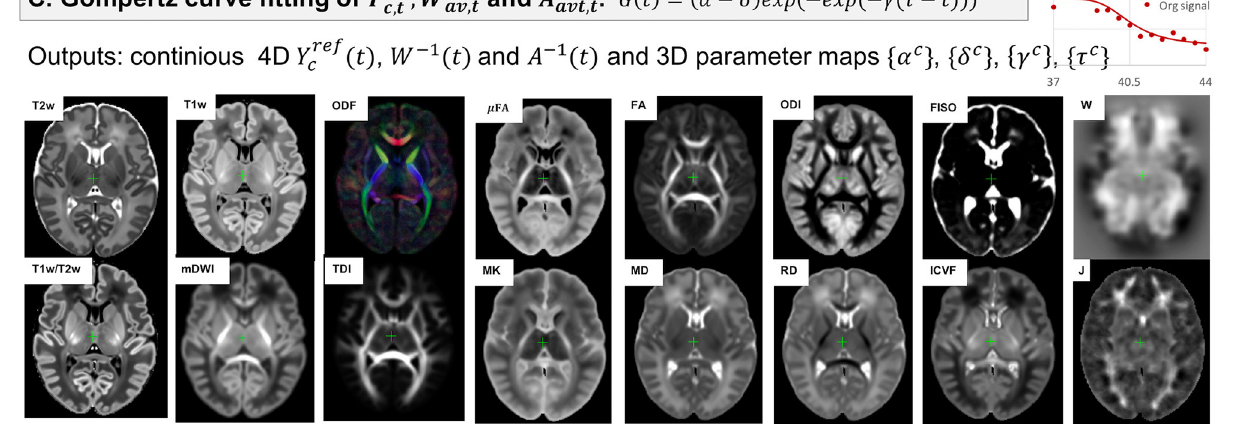
where α c , δ c , γ c and τ c are the Gompertz function parameters of metrics c = { T1w; T2w; T1w/T2w; mDWI; ODF: SH